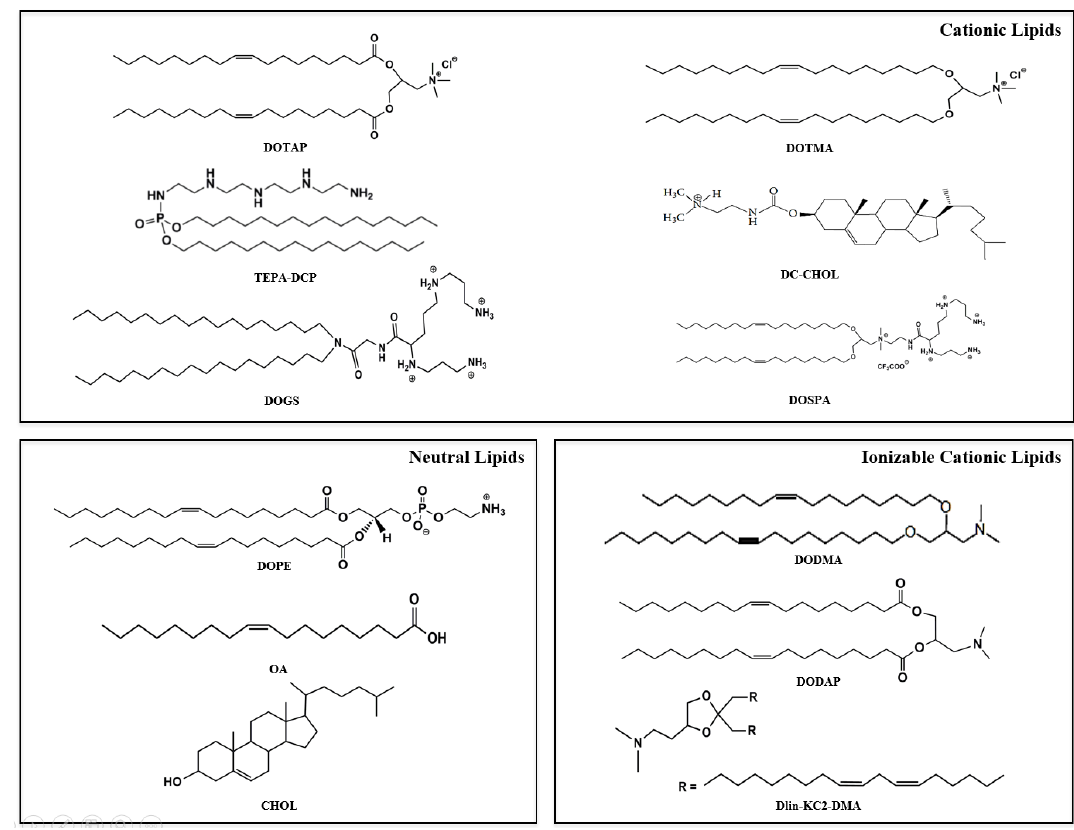
Figure 1. Chemical structure of some lipids commonly used to prepare lipid nanovectors used to deliver ncRNA.